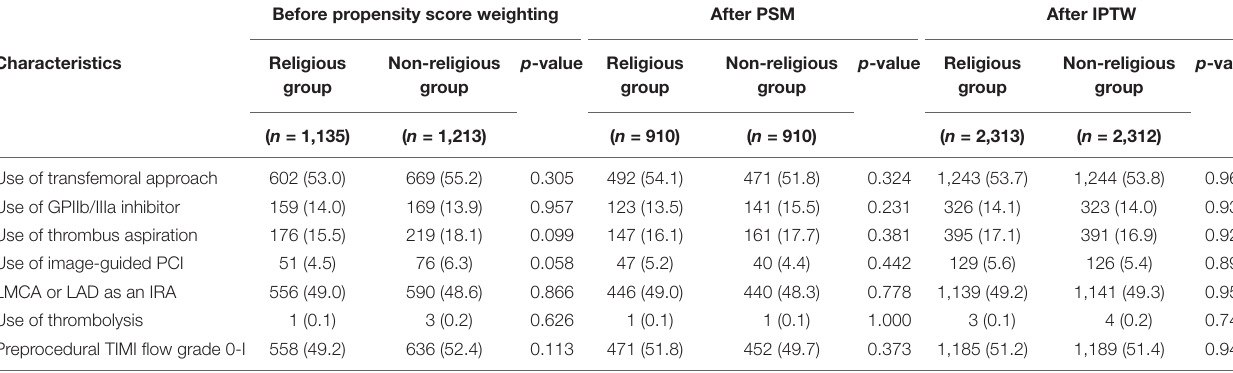
TABLE 2 | Coronary angiographic and procedural characteristics of the study population.